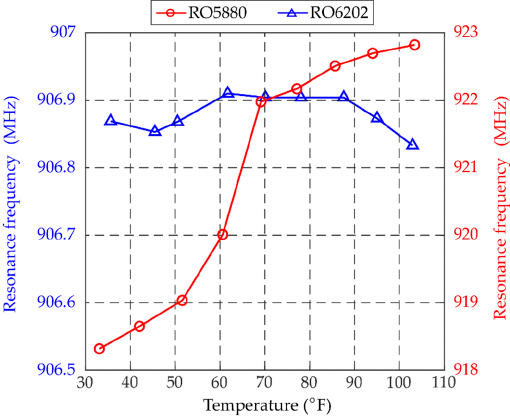
Figure 8. Resonance frequency change during temperature chamber test.